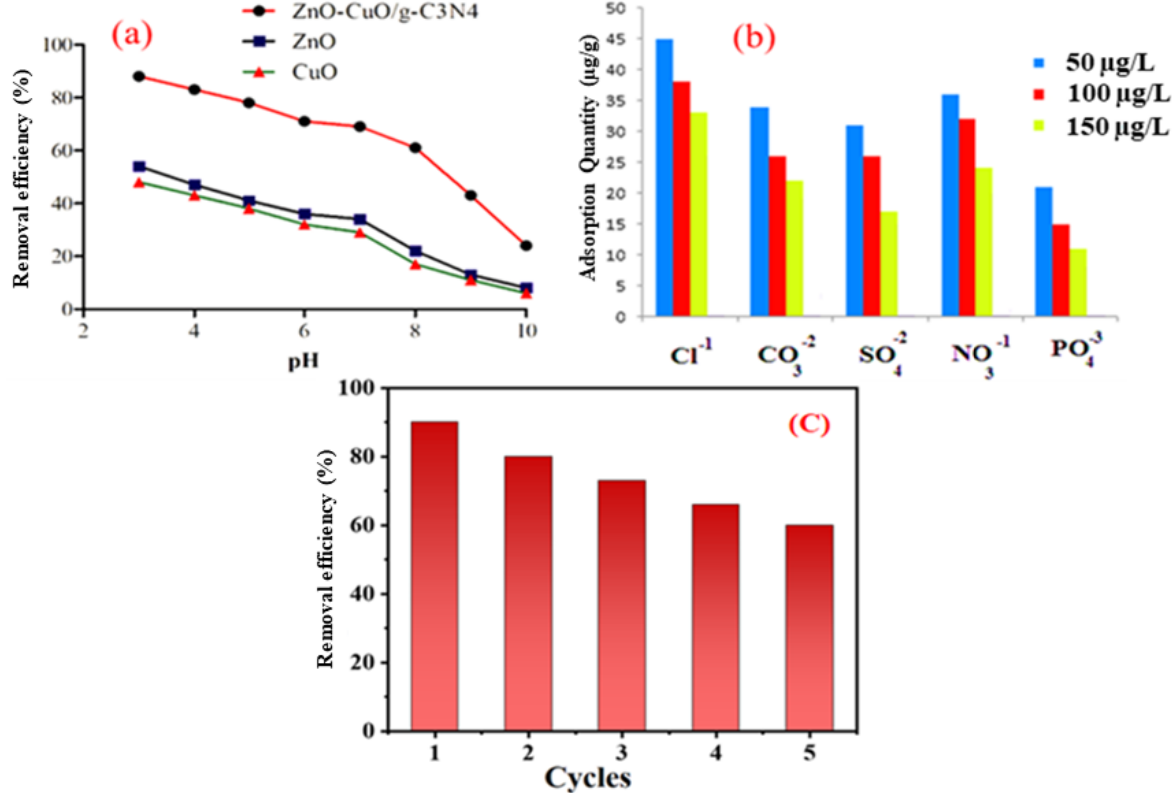
Figure 6. ( a ) Effect of pH ( b ) interfering ions on the removal of As(III) by ZnO–CuO/g–C 3 N 4 composite, ( c ) removal rate (%) of As(III) by ZnO–CuO/g–C 3 N 4 nanomaterial composites in five recycling steps.